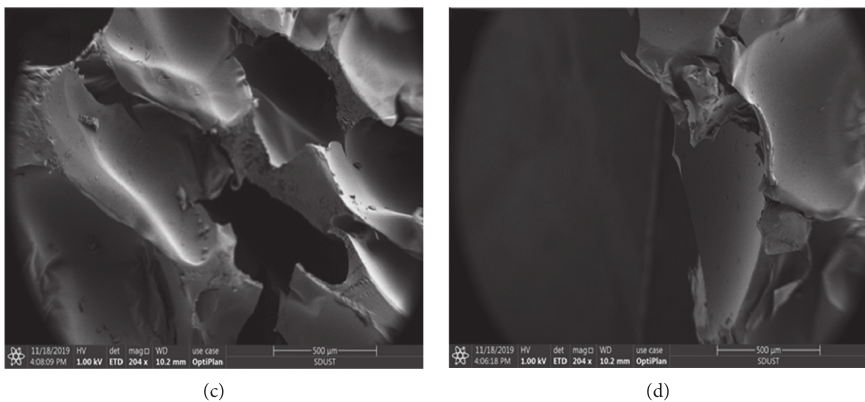
Figure 4: The SEM images of PCS after uniaxial compression experiment: (a) specimen 1 in group I with a surfactant ratio of 0.5; (b) specimen 5 in groupIIwithasurfactantratioof0.6;(c)specimen9ingroupIIIwithasurfactantratioof0.7;(d)specimen13ingroupIVwithasurfactantratioof0.8.